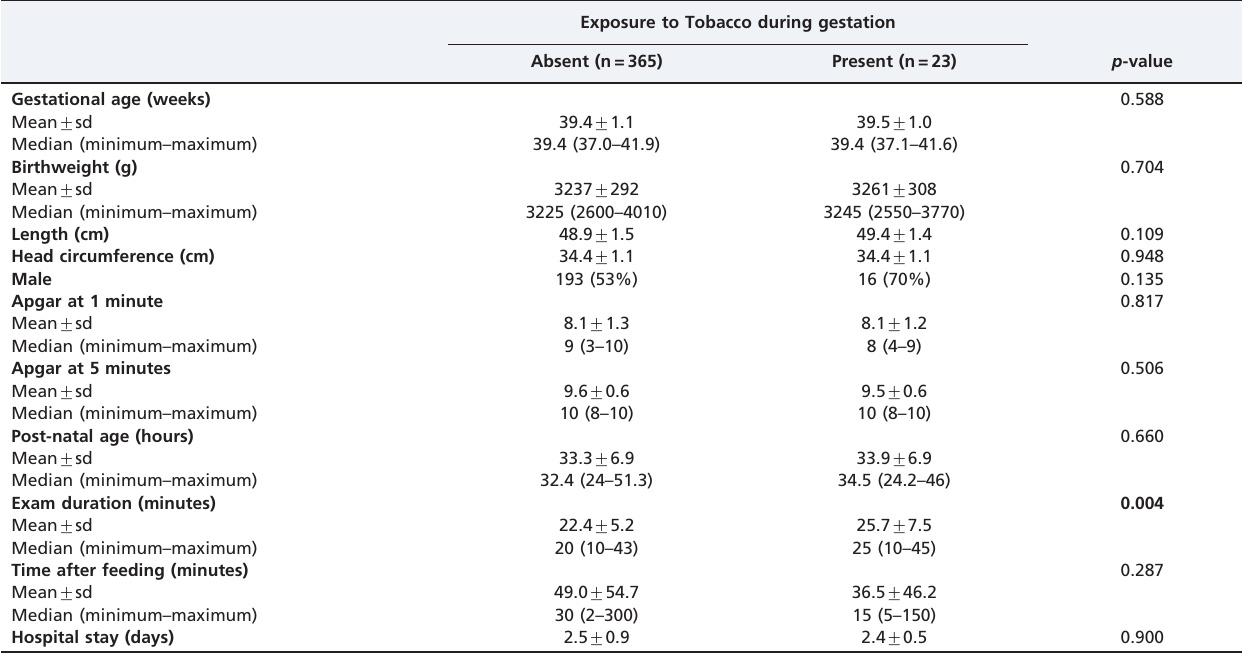
Table 2 - Neonatal demographic characteristics and neonatal data at the time of NNNS assessment. Exposure to Tobacco during gestation